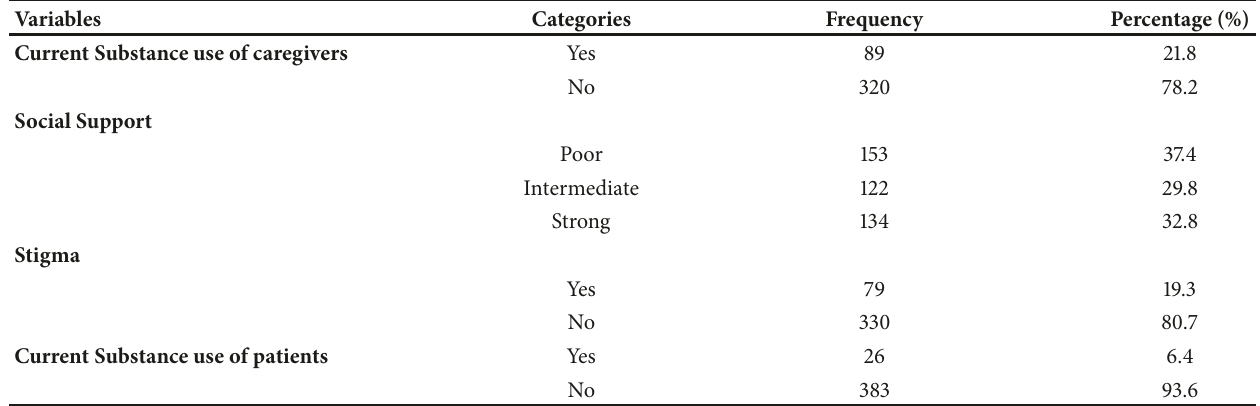
Table 3: Behavioral and psychosocial characteristics of caregivers of patients with epilepsy at Amanuel Mental Specialized Hospital, Addis Ababa, Ethiopia, 2017 (n=409).